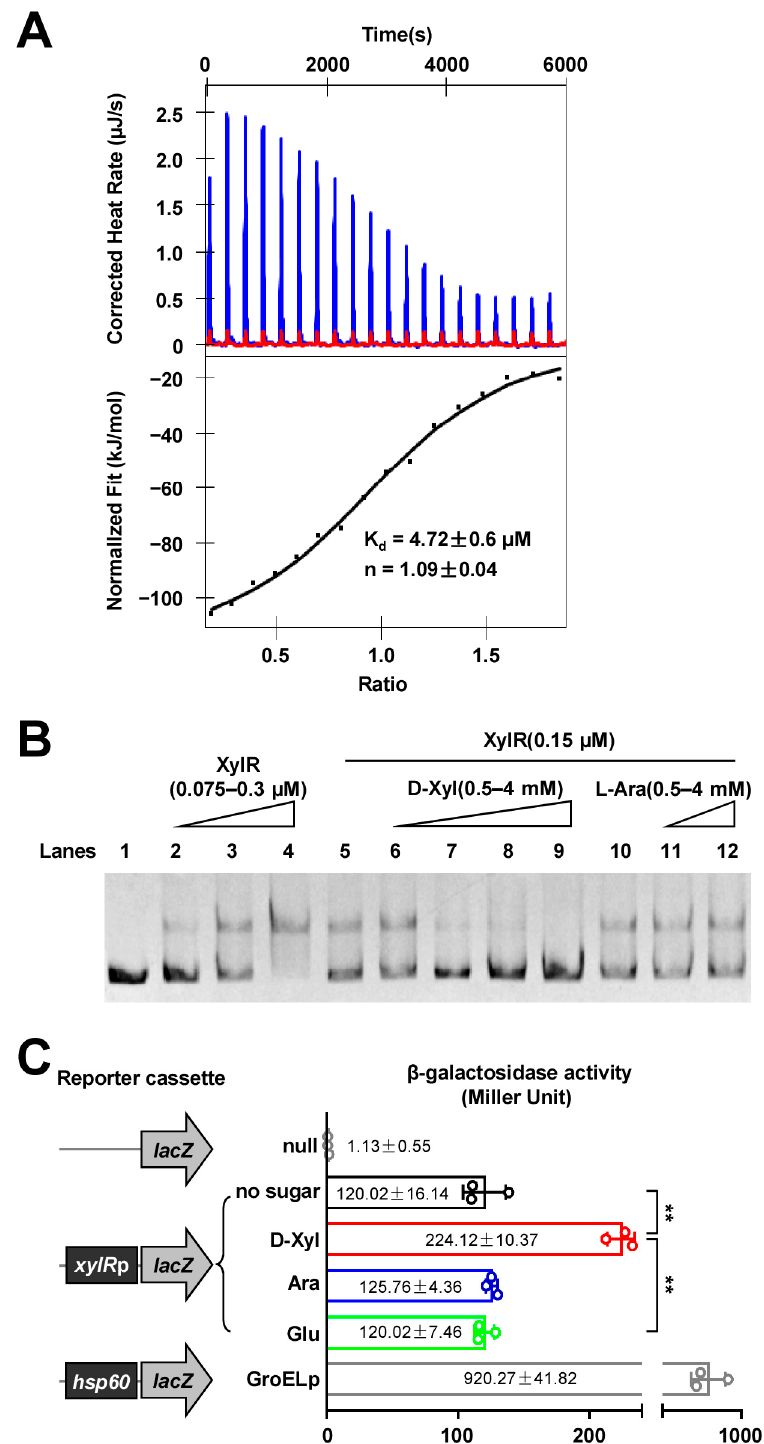
Figure 2. Assay for the interaction between D-xylose and XylR. ( A ) ITC assays for the physical inter- action of D-xylose with the XylR protein. Original titration data and integrated heat measurements are shown in the upper and lower plots, respectively. The solid line in the bottom panel represents the best fit to a one-site binding model of the interaction of XylR with D-xylose. ( B ) EMSA assays for the effect of D-xylose on DNA-binding activity of XylR. xylR p was co-incubated with increasing amounts of XylR protein (lanes 1–4). The concentration of XylR was immobilize and then increasing amounts of D-xylose (0.5–4 mM) (lanes 6–9) or L-Ara (0.5–4 mM) (lanes 11–12) were added into the reactions. ( C ) β -galactosidase activity assays. The effect of D-xylose on the genes expression was assayed